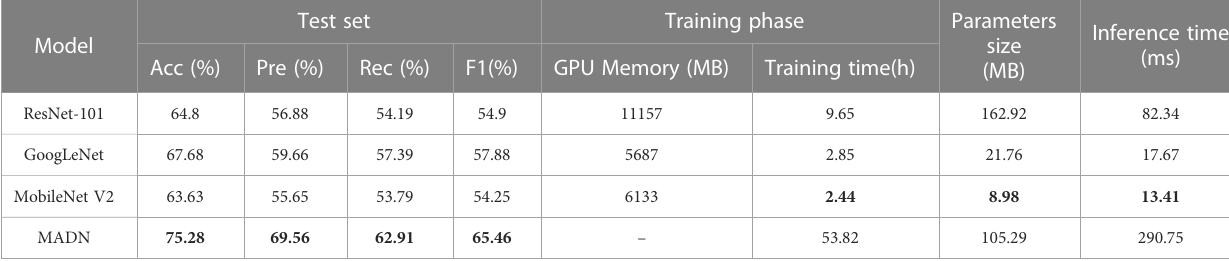
The bold values indicate the best values in this